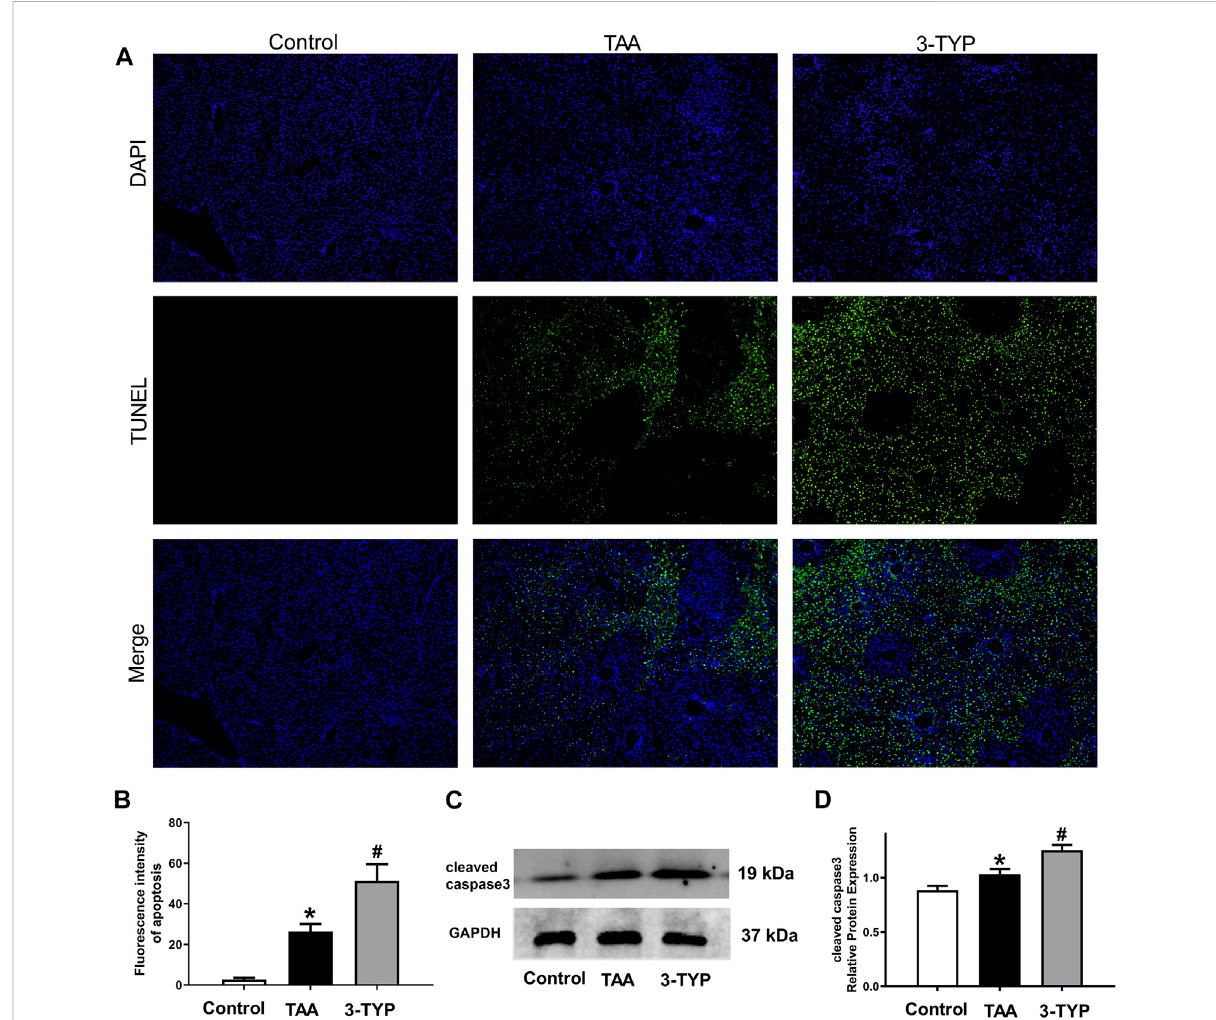
Effects of 3-TYP on liver cell apoptosis in each group, n = 10 per group. (A) The apoptosis cells of liver samples were measured by TUNEL staining. (B) Quanti fi cation of apoptosis. (C) The expressions of cleaved caspase 3 were detected by western blotting. (D) The quantitative values